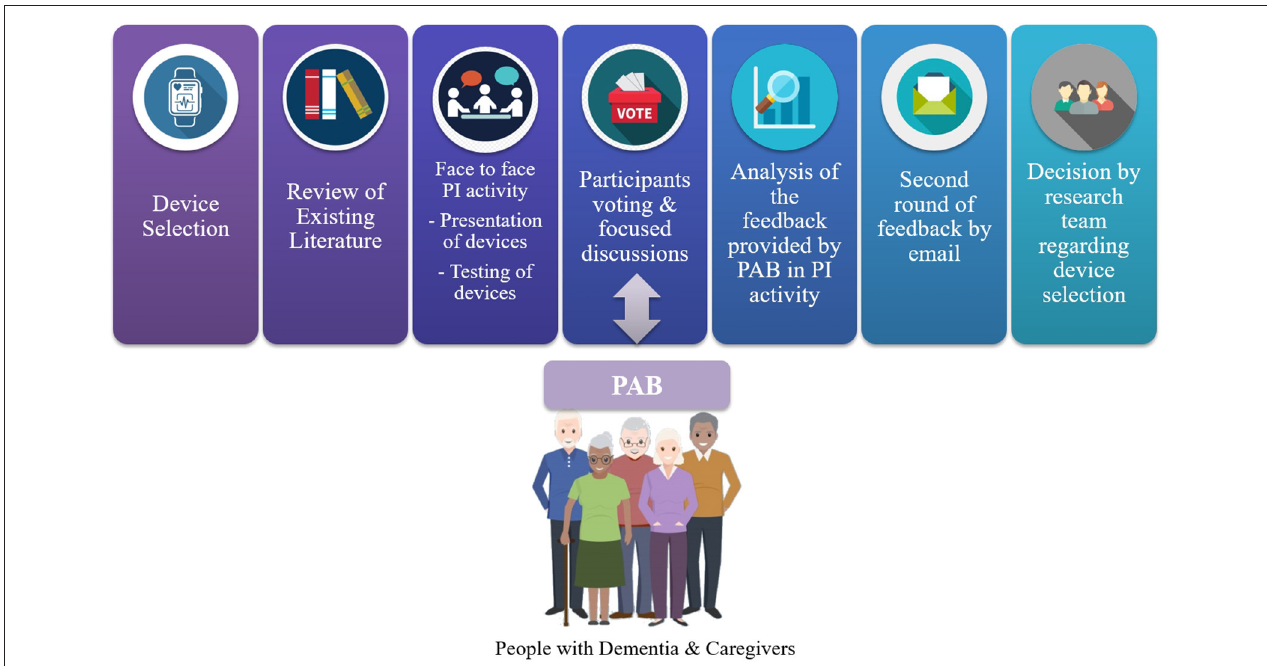
FIGURE 1 | The framework of the study centered around people with dementia and their